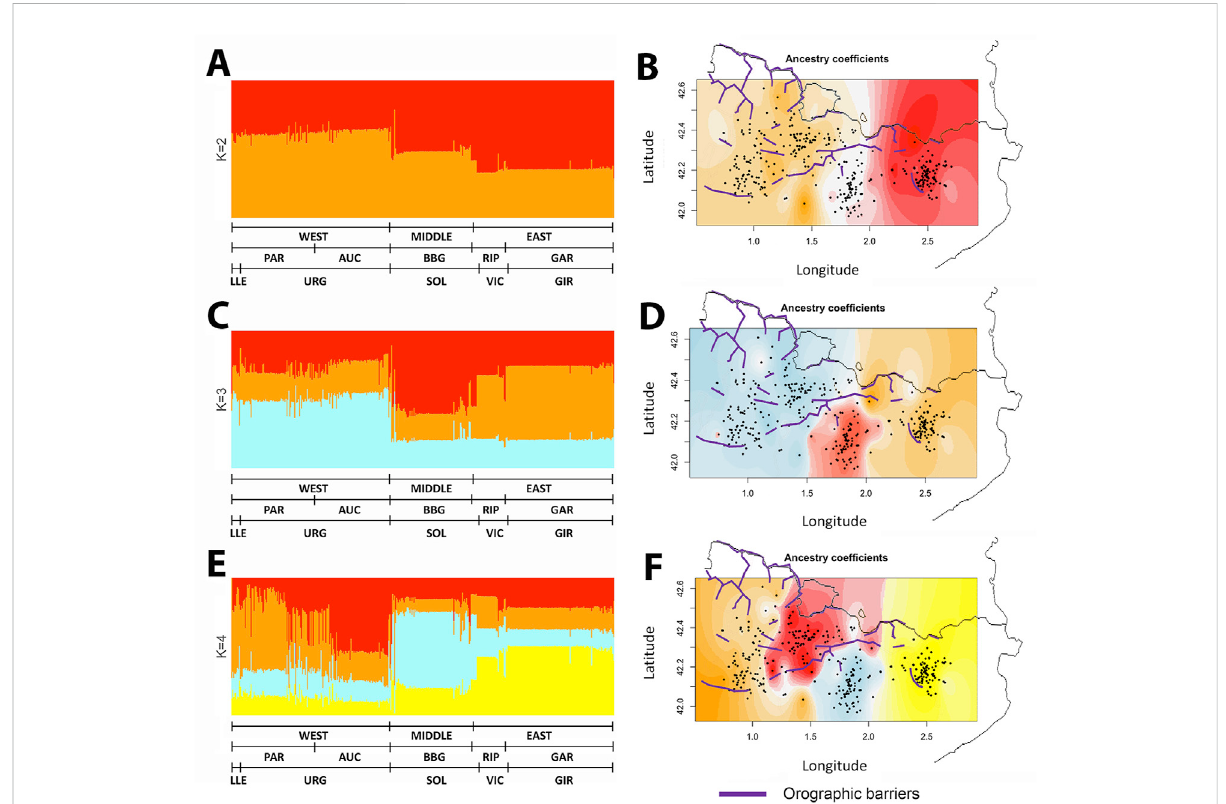
FIGURE 5 SpatialdistributionanalysisoftheancestryofGENPIRindividuals.Barplot (A)(C),(E) andGeographical (B)(D),(F) patterndistributionofancestry componentsofGENPIRsamplesassumingK=2toK=4.In (A)(C) and (E) ,GENPIRsamplesareassignedtoWEST,MIDDLEorEASTcatalanPyrenees regions, comarques (PAR, Pallars-Ribagorça; AUC, Alt Urgell-Cerdanya; BBG, Berguedà and Solsonès; RIP, Ripollès and GAR, Garrotxa) and bishoprics (LLE,Lleida;URG,Urgell;SOL, Solsona; VIC, Vic andGIR, Girona), accordingto their centroid assignment. In (B) (D) and (F) ,individual values of the ancestry components of GENPIR samples for K= 2 to 4 are plotted over the geographic location of each subject. Purple line denotes main orographic